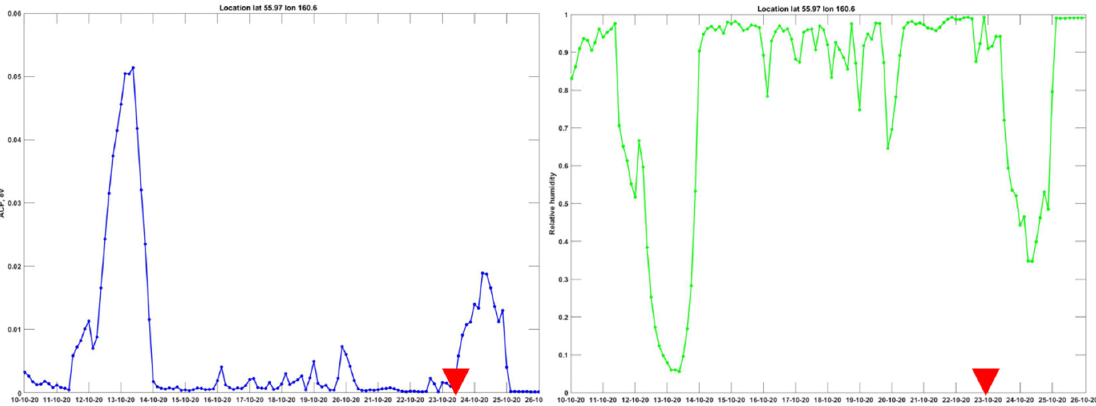
Figure 8. Left panel—ACP variations over the volcano Bezymyanny (Kamchatka peninsula, Russia) around the time of volcano eruption 22 October 2020; right panel—relative humidity variations over the volcano Bezymyanny (Kamchatka peninsula, Russia) around the time of the volcano eruption on the 22 October 2020. The moment of eruption is marked by red triangles.